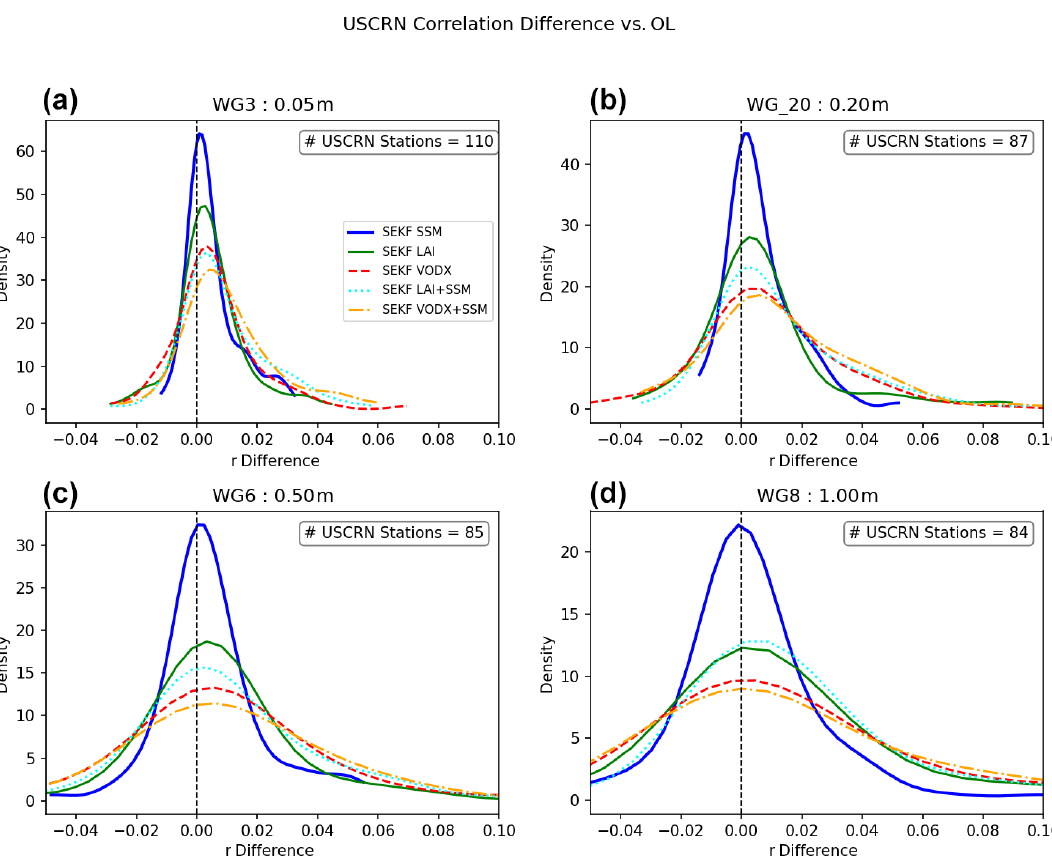
Figure 9. Probability distribution functions of the distribution of correlation differences between the OL and SEKF SSM (solid bold blue line), SEKF LAI (solid green line), SEKF VODX (dashed red line), SEKF LAI SSM (dotted cyan line), and SEKF VODX SSM (dash-dotted orange line) for USCRN at (a) WG3 (5cm), (b) WG_20 (20cm), (c) WG6 (50cm), and (d) WG8 (100cm) between 2011 and